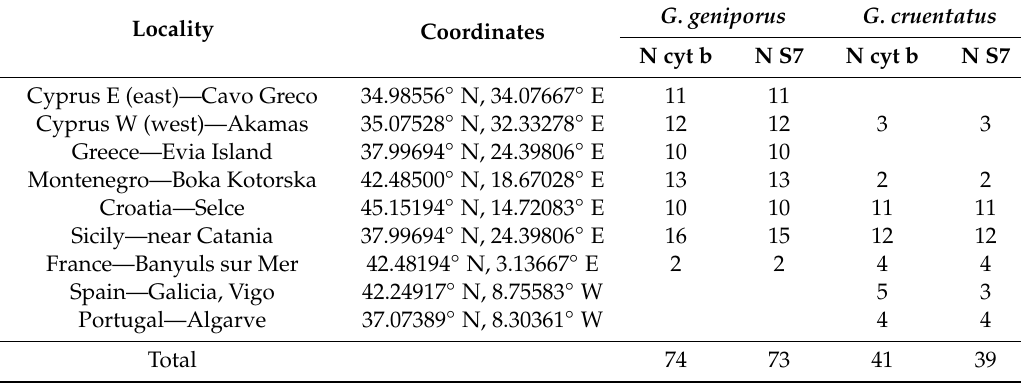
Table 1. Sampling sites and number of analysed specimens of Gobius geniporus and G. cruentatus for cytochrome b and